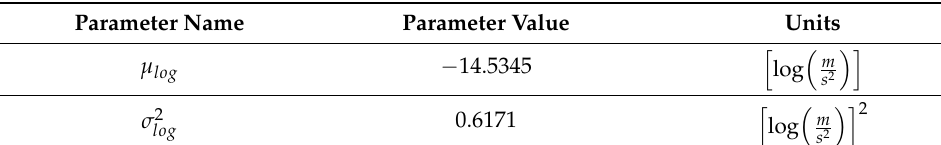
Figure 15. ( a ) FFT of vibration signal measured on the test bench and ( b ) PDF of the peaks in the range of 10–13 kHz.